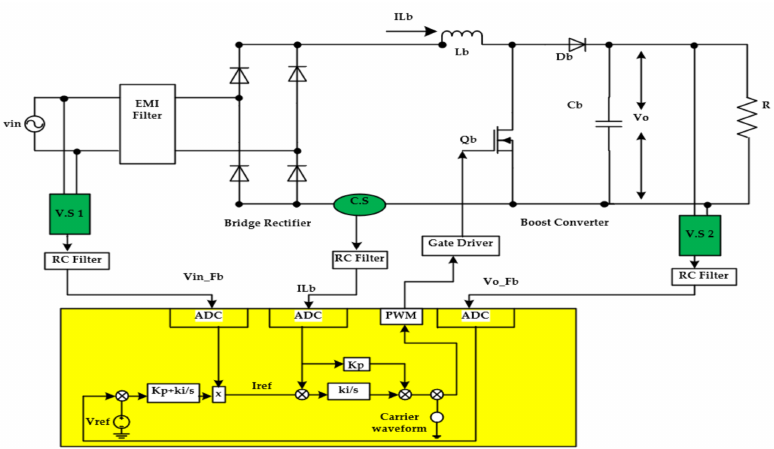
Figure 23. Complete schematic diagram of the CCM-PFC with the proposed digital control technique. At the rated input of (220 V rms , 60 Hz) and full load condition of P o = 2500 W and V bus = 400 V, Figure 24 shows the waveform of the inductor current (I Lb ) with the reference current (Iref) for the PI current controller. We observed distortion at the inductor current around the zero-crossing point due to the slow dynamic response of the PI controller and the failing of the inductor current (I Lb ) to track the reference current (I ref